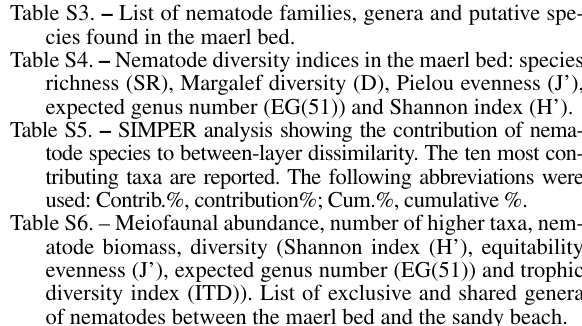
Table S3. – List of nematode families, genera and putative spe- cies found in the maerl bed. Table S4. – Nematode diversity indices in the maerl bed: species richness (SR), Margalef diversity (D), Pielou evenness